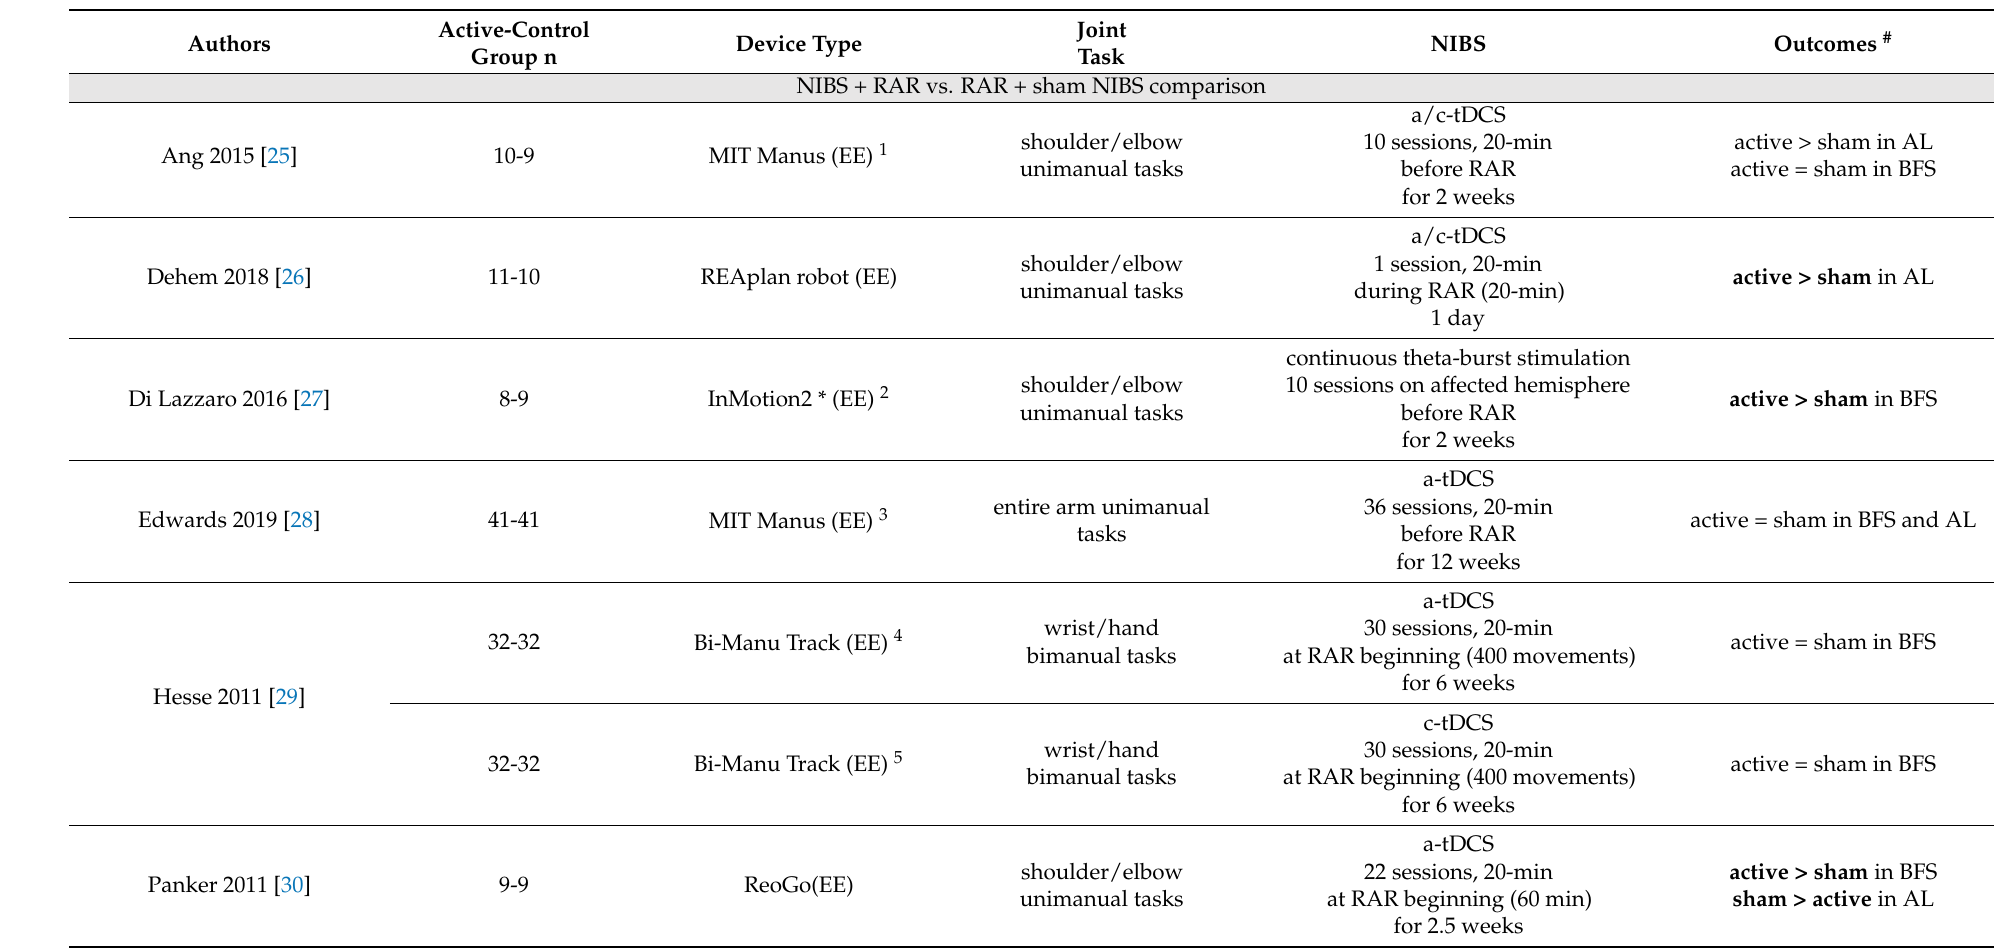
Table 1. Characteristics of upper limb